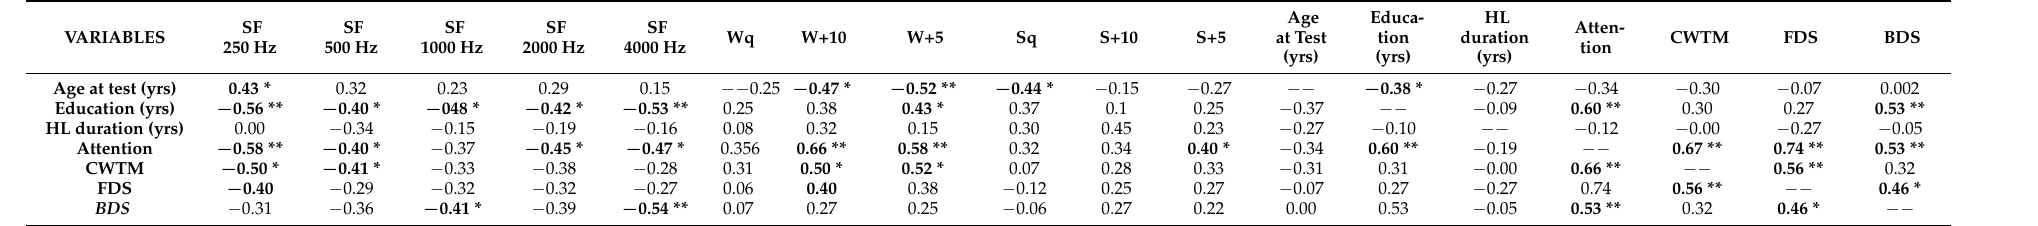
Table 4. Relationships between sociodemographic, cognitive, and audiological variables in the overall study group (n =